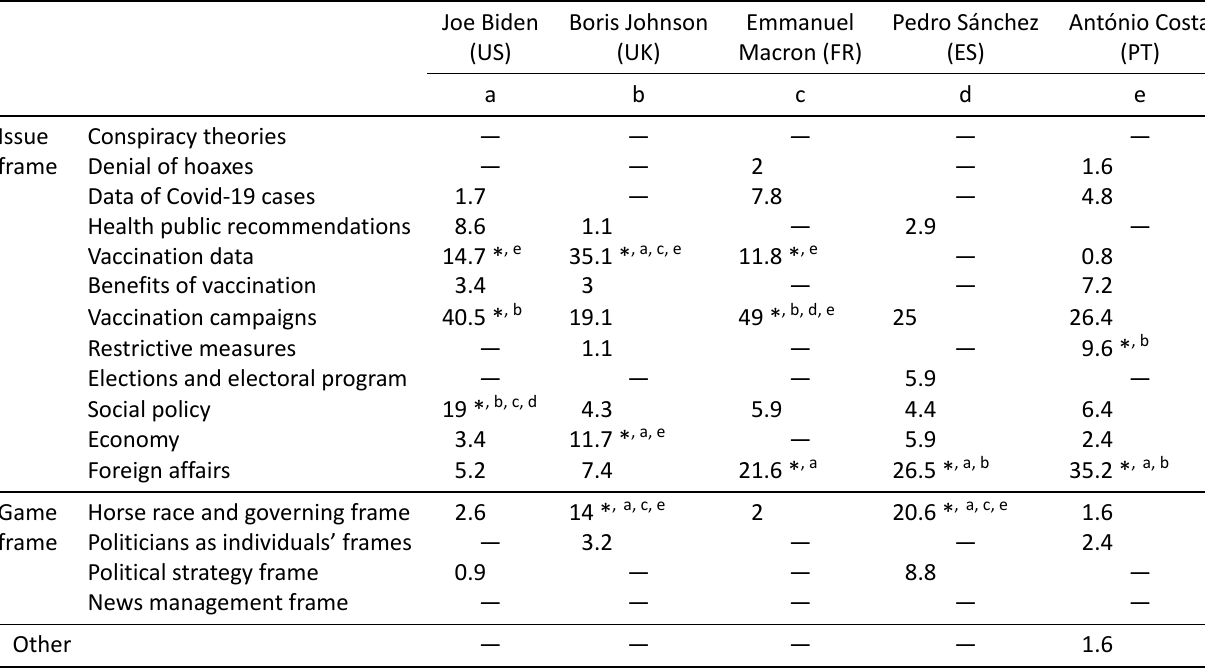
Table 2. Issues and strategies in the tweets of the heads of government